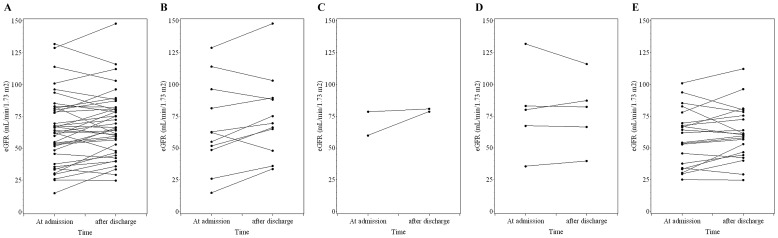
Changes in eGFR for (A) all patients (n = 40), and those evaluated at (B) 3 months after discharge (n = 11), (C) 6 months after discharge (n = 2), (D) 9 months after discharge (n = 6), and (E) 12 months after discharge (n = 21).